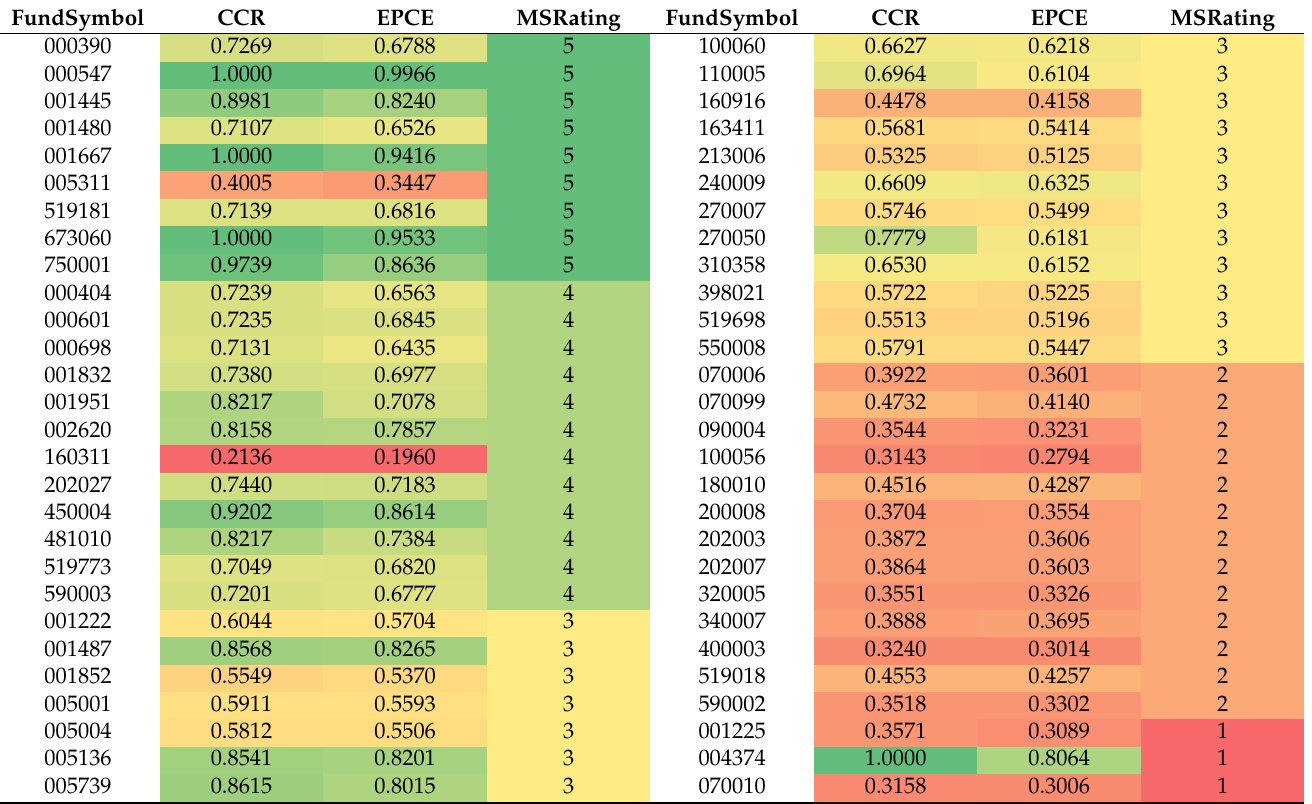
Table 7. The evaluation results of different